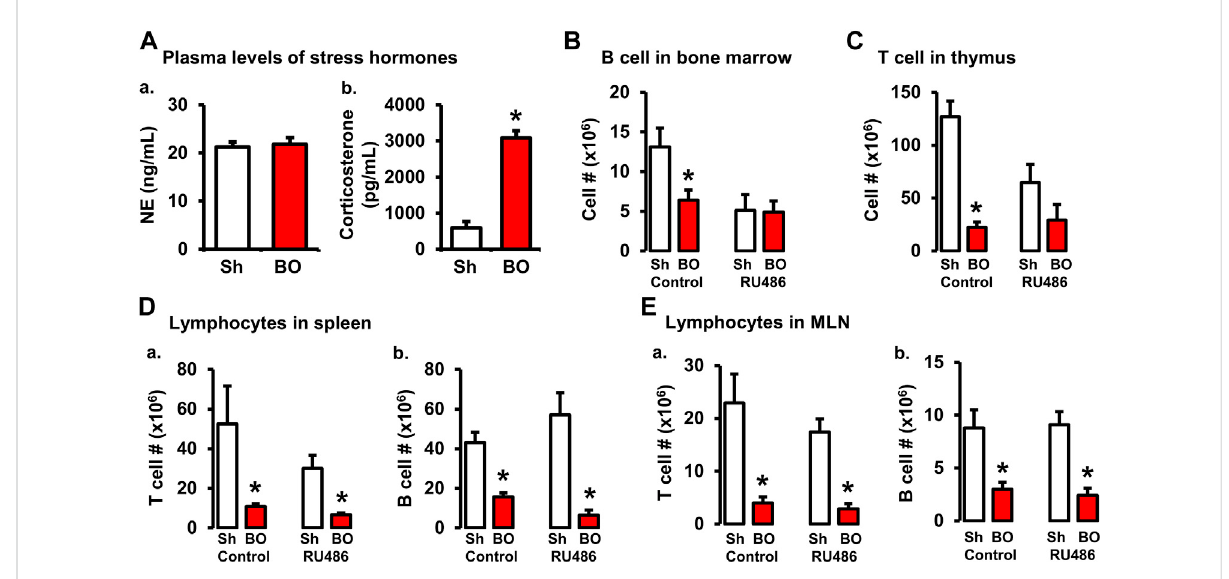
FIGURE 5 Role of corticosterone in BO-associated lymphopenia in lymphoid organs. (A) Plasma levels of norepinephrine (A) and corticosterone (B) in sham(Sh) and obstruction (BO) rats. N =5per group. * p ≤ 0.05 vs.sham. (B) Effect ofcorticosteroid receptorantagonist RU486 onBcell numbersin bonemarrowinshamandBOrats. (C) EffectofRU486onTcellnumbersinthymusinshamandBOrats. (D) EffectofRU486onTcells (A) andBcells (B) in the spleen in sham and BO rats. (E) Effect of RU486 on T cells (A) and B cells (B) in the MLN in sham and BO rats. N = 5 or 6 for B-E. * p ≤ 0.05 vs. sham in the treatment